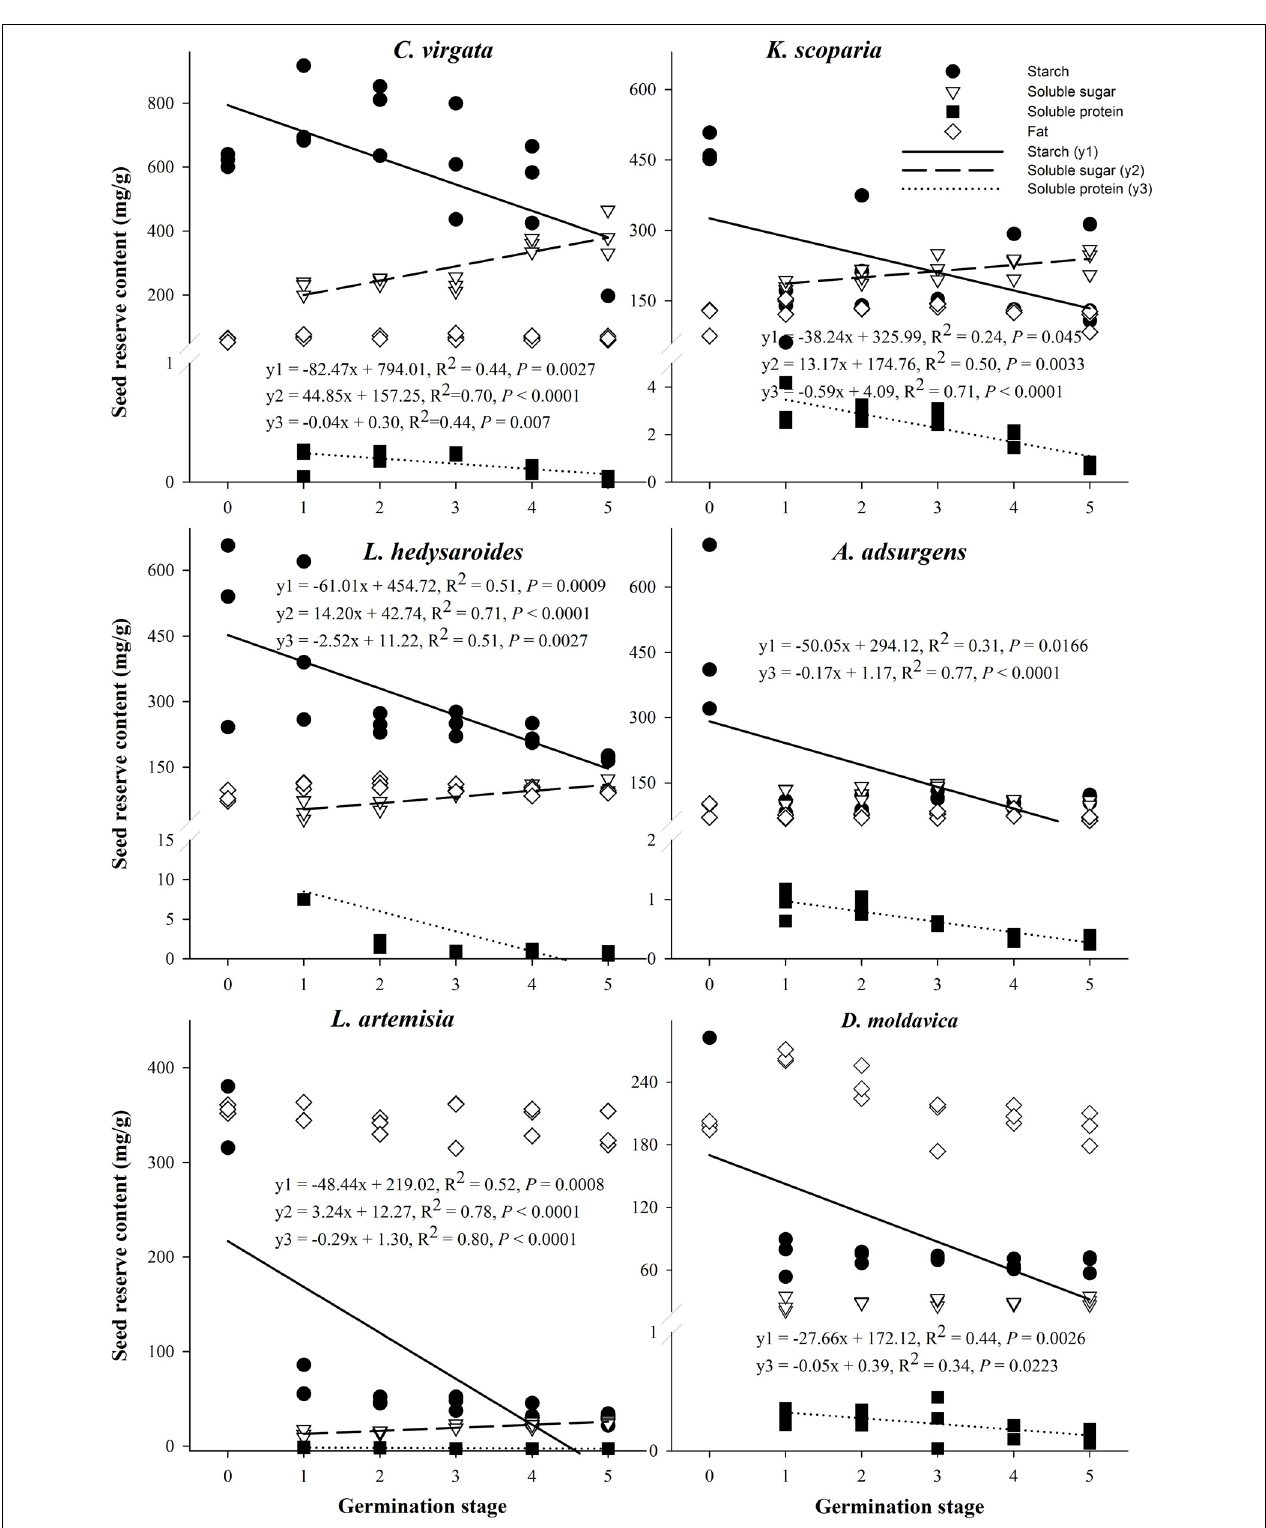
FIGURE 4 | Regression analysis between starch, fat, soluble protein, soluble sugar, and germination stage for the six species Kochia scoparia , Chloris virgata , Astragalus adsurgens , Lespedeza hedysaroides , Leonurus artemisia, and Dracocephalum moldavica . (0) Dry seeds; (1) imbibition; (2) 1% germination; (3) 50% germination; (4) highest germination; (5) early